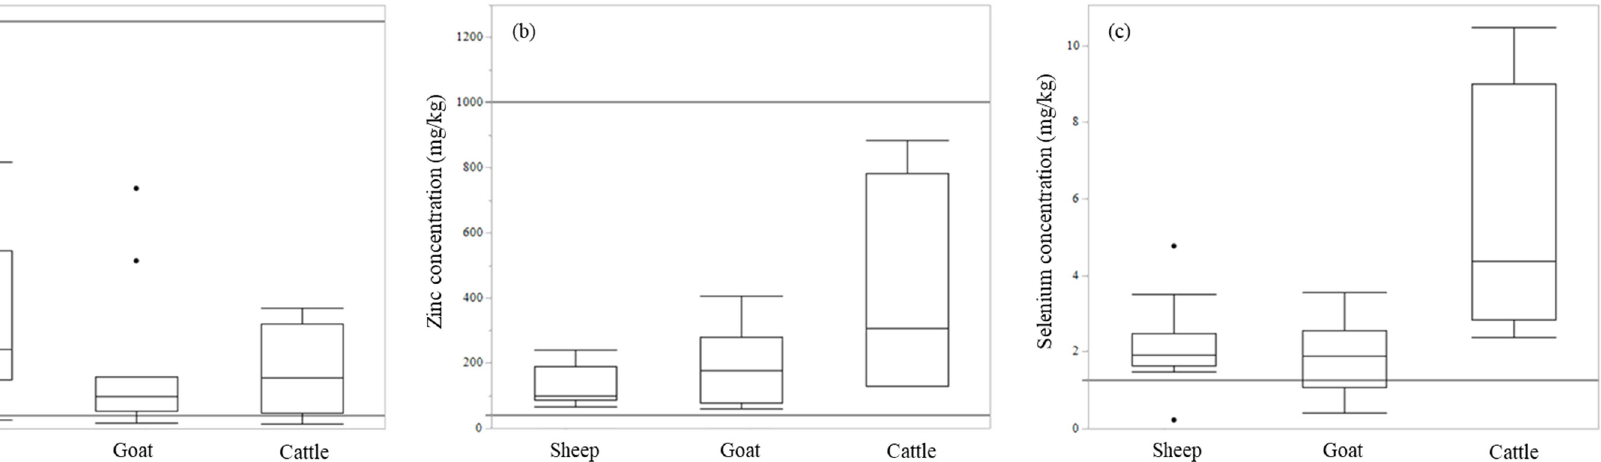
Figure 3. Copper, zinc and selenium concentration in liver. Copper ( a ), zinc ( b ) and selenium ( c ) concentration in liver samples are shown in a box plot. The black line shows toxic and deficient level in ( a ) and ( b ), and marginally deficient level in ( c ). Deficient lines in ( b ) and ( c ) indicated 40 and 1.25 mg/kg although they had range 20—40 and 0.6—1.25 mg/kg respectively.